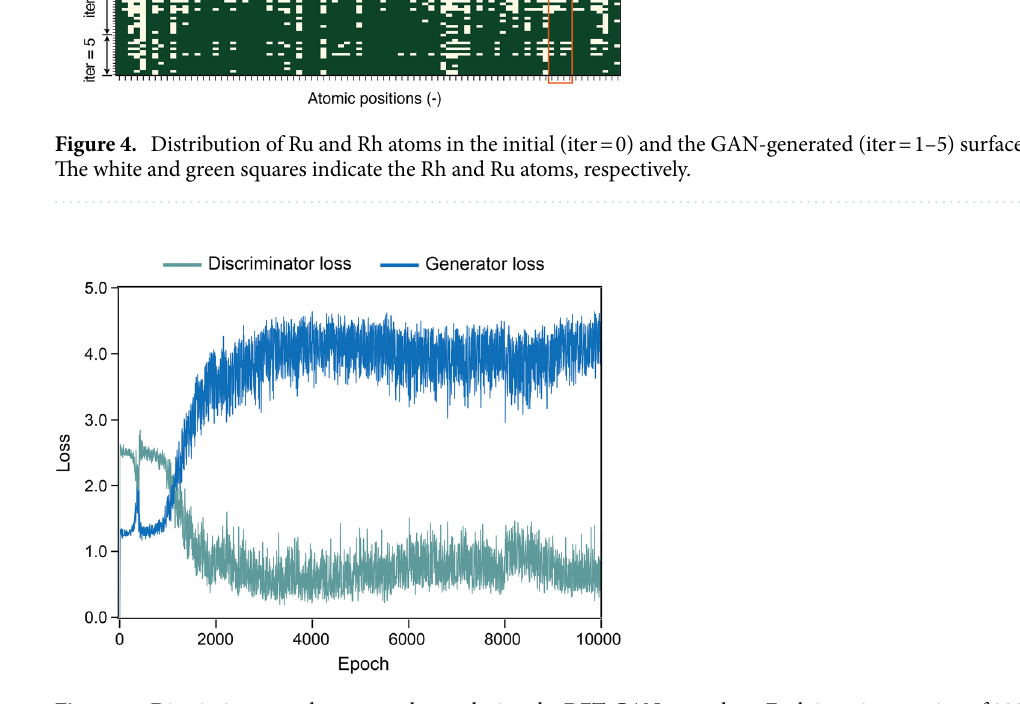
Figure 5. Discriminator and generator losses during the DFT-GAN procedure. Each iteration consists of 2000